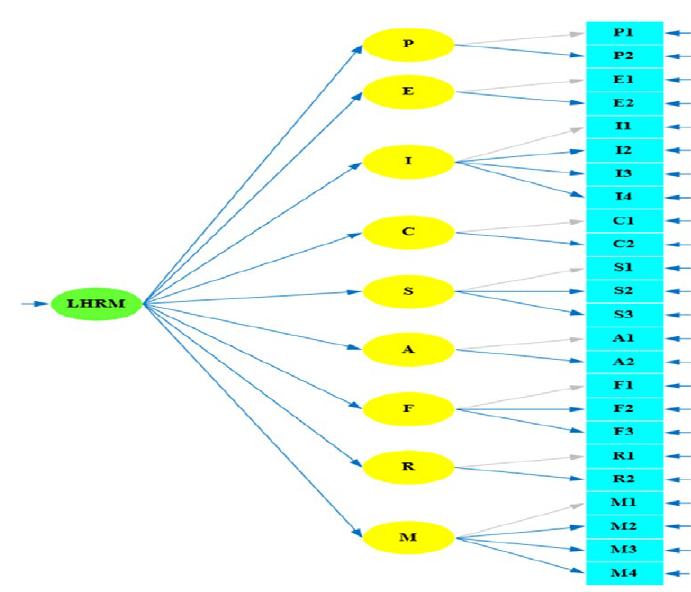
Fig. 1: The conceptual model of “LHRM in the Islamic City Council of Tehran”